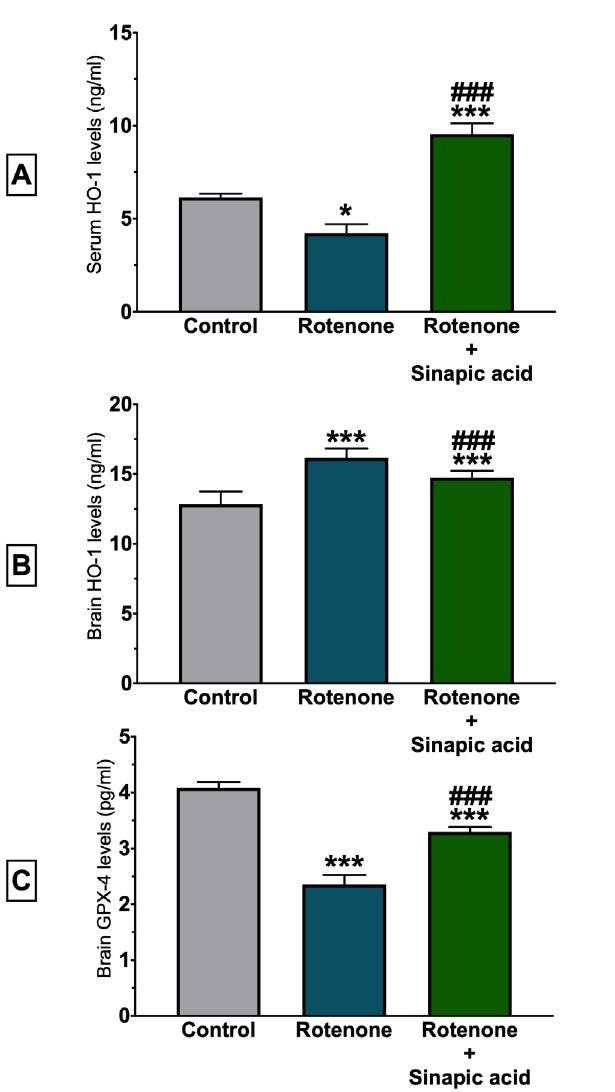
FIGURE 4 - While serum HO-1 levels (A) decreased after rotenone, brain levels of HO-1 were increased (B). Rotenone significantly decreased GPx-4 levels in the brain tissue (C). However, sinapic acid increased serum HO-1 levels (A), which attenuated rotenone-induced increase in the brain tissue (B). Additionally, sinapic acid prevented rotenone- induced decrease of GPx-4 in the brain (C).All data expressed as mean ± SD. ***p<0.001, *p<0.05 versus control group, ### p<0.001 versus rotenone group.